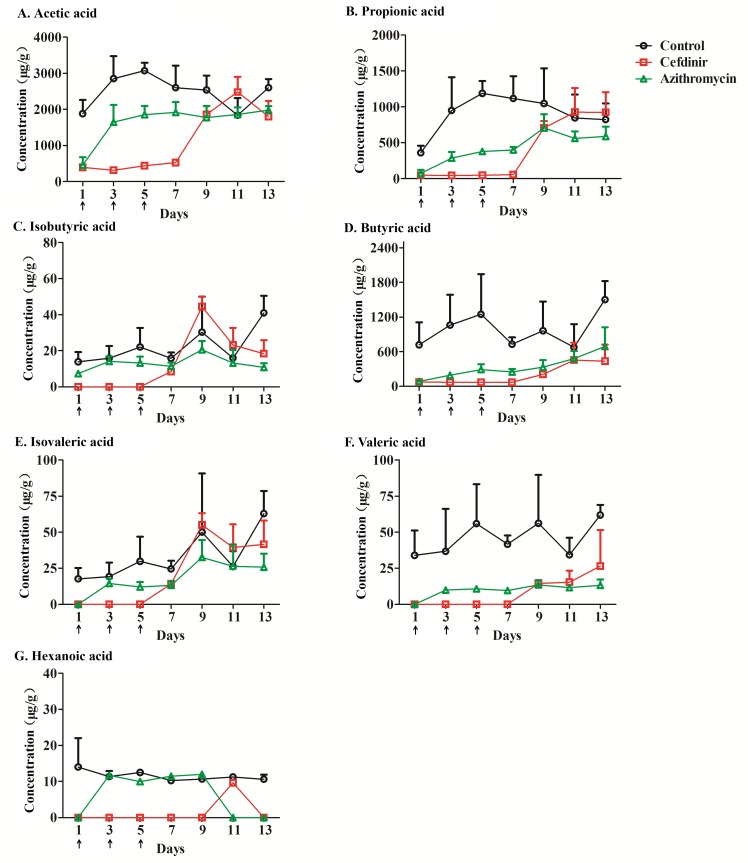
The concentrations of seven SCFAs extracted from fecal samples as a function of time.Antibiotics (cefdinir or azithromycin) were administered for the first 6 days. (A) acetic acid; (B) propionic acid; (C) isobutyric acid; (D) butyric acid; (E) isovaleric acid; (F) valeric acid; and (G) hexanoic acid. Arrow means administration of antibiotic.